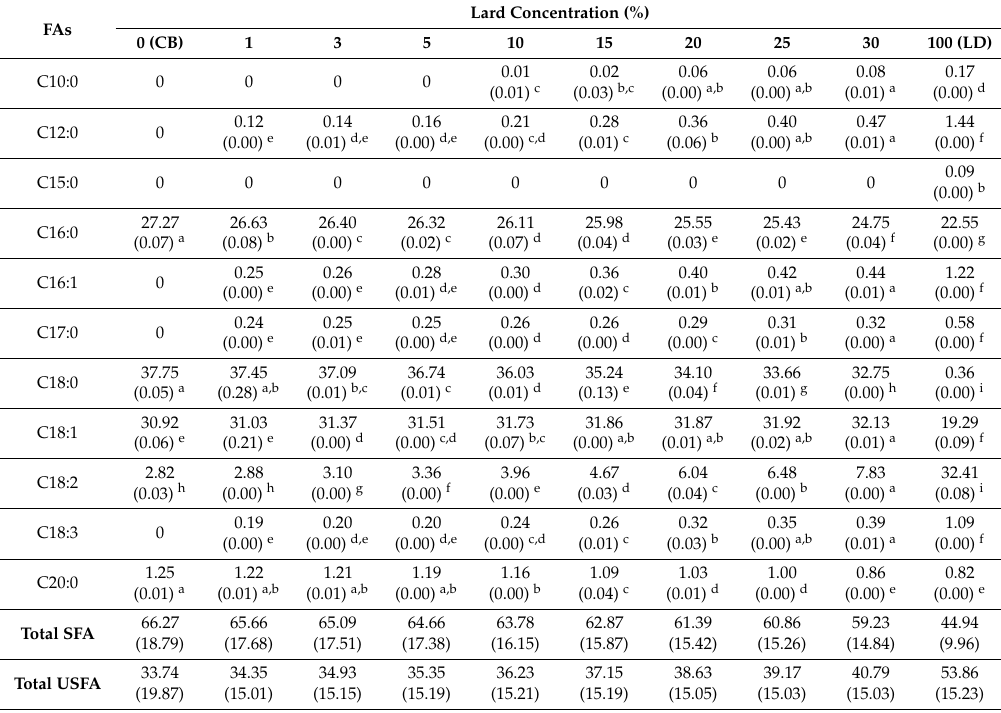
Table 3. Composition of fatty acids in lard, cocoa butter, and their